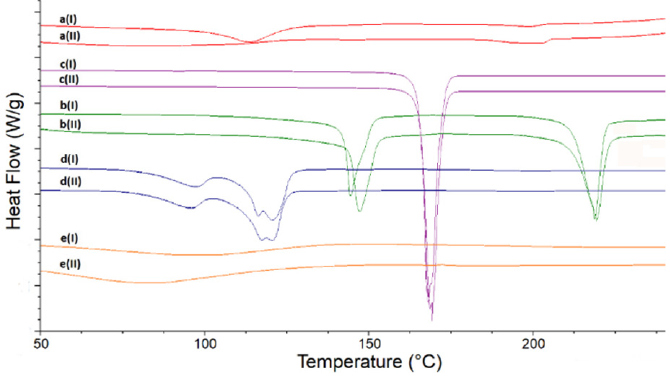
Figure 2 . DSC curves for linagliptin (a), lactose (b), mannitol (c), magnesium stearate (d) and polyvinylpyrrolidone (e) in the non-stressed (I) and stressed (II) samples. The non-stressed physical mixtures of LINA with each of four excipients (Figure 3, upper curves) revealed some changes concerning LINA, suggesting its potential interactions with the second component at ambient conditions. In the mixtures of LINA with LAC, LINA with MAN, and LINA with PVP, the first LINA endotherm was observed at higher temperatures, i.e., at 114.9 ◦ C, 115.4 ◦ C and 114.7 ◦ C, respectively. It seems that the